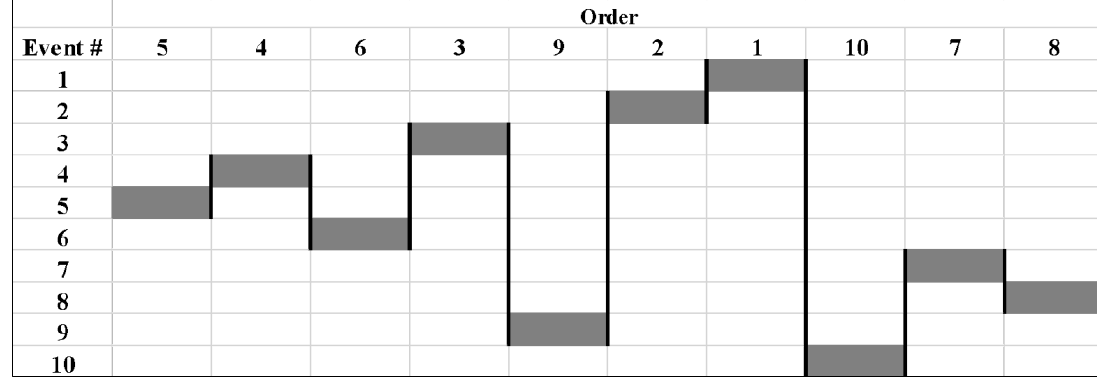
Figure 12. Inverse lazy serpent schedule.